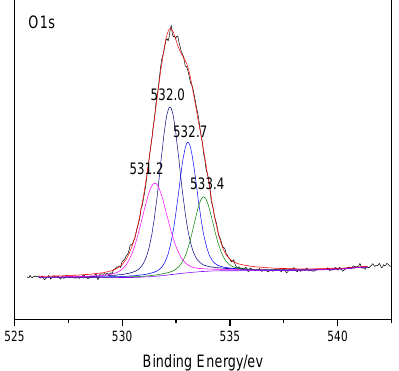
Figure 1. XPS O 1s spectrum of Bulianta coal.